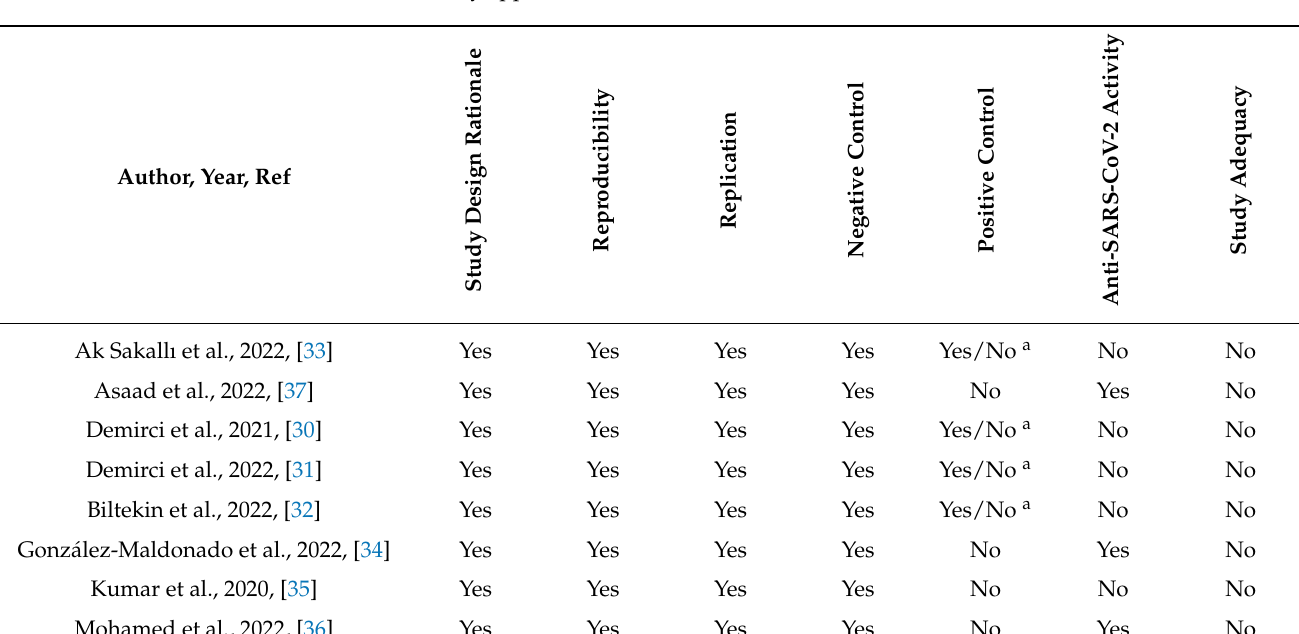
Table 3. Quality appraisal results of the included